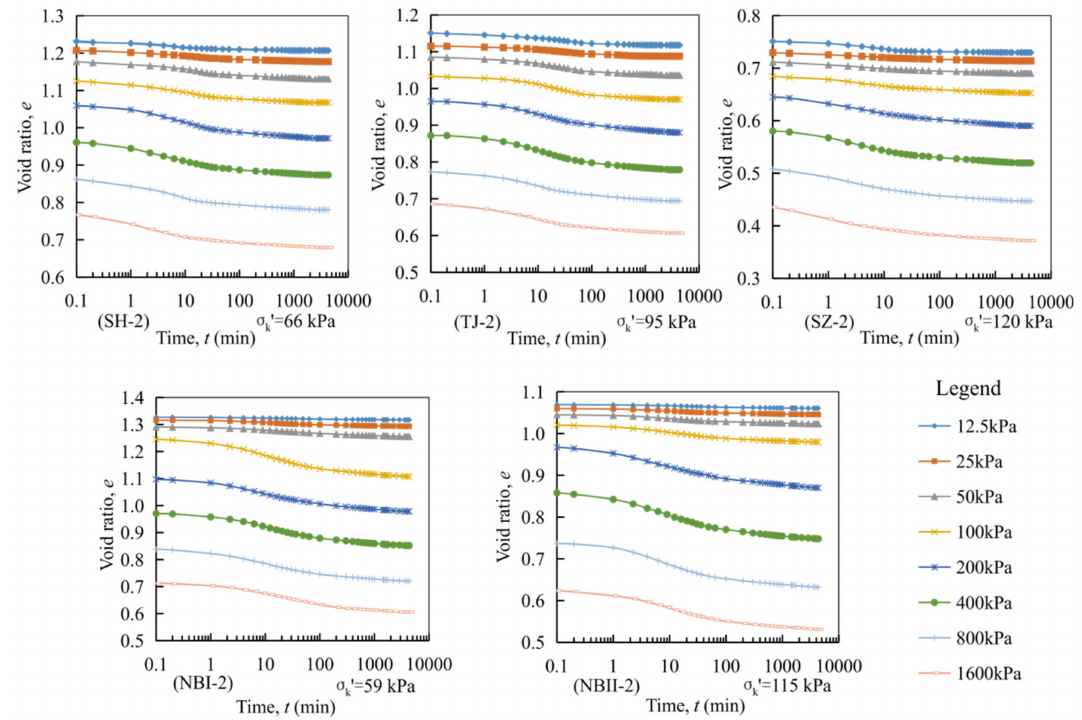
Figure 7. e -lg t curves of the one-dimensional consolidation creep